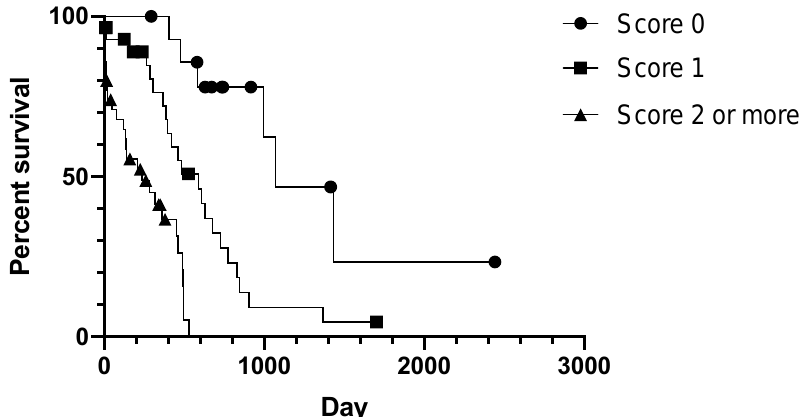
Figure 3. Kaplan–Meier plot of AGASAC cases stratified according to the clinical algorithm detailed in Table 4. Log-rank p < 0.0001, all individual curve comparisons p < 0.017 (Bonferroni-corrected level of significance).